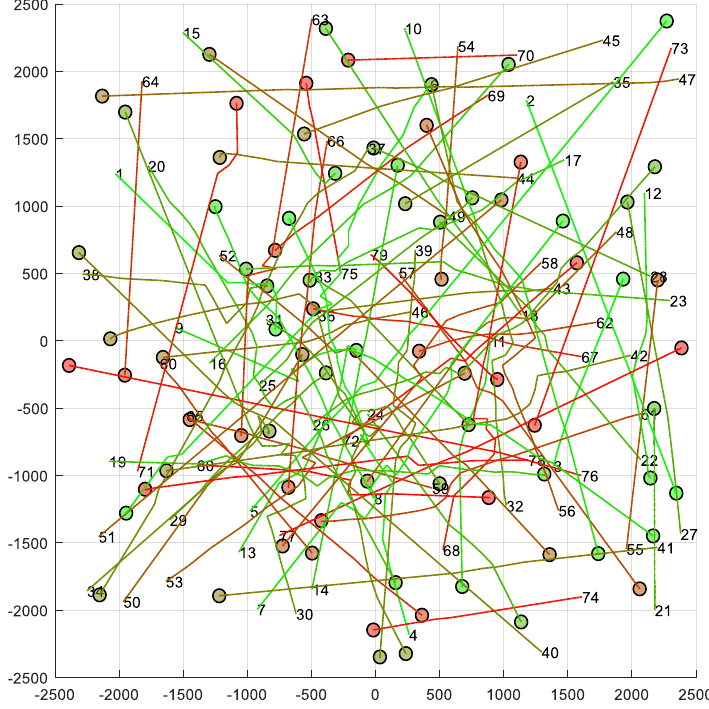
Figure 10. Random scenario with 80 UAVs and PCAN. Each number represents the initial position of a UAV; each circle represents the current position of the UAV and its safety radius; each line represents the trajectory followed by the UAV. Units on the X and Y axes are meters.